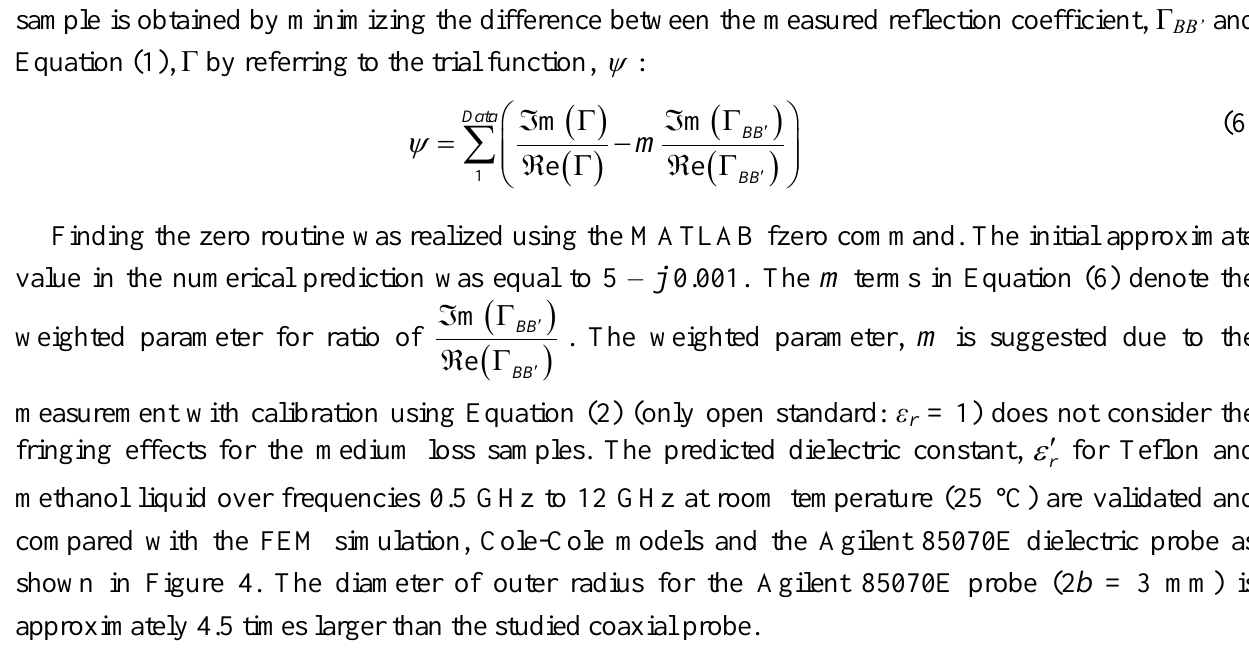
Figure 4. Variation in dielectric constant, with frequency, f for Teflon and liquid methanol at (25 ± 1)